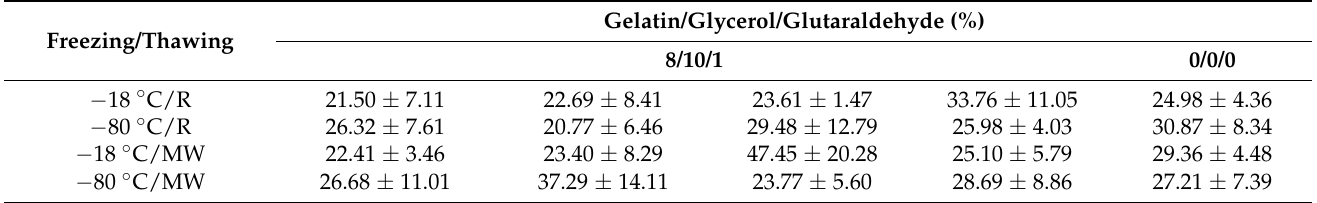
Table 6. Meat WBSF values ± SD [N] with crosslinked coating and without coating depending on the method of freezing and